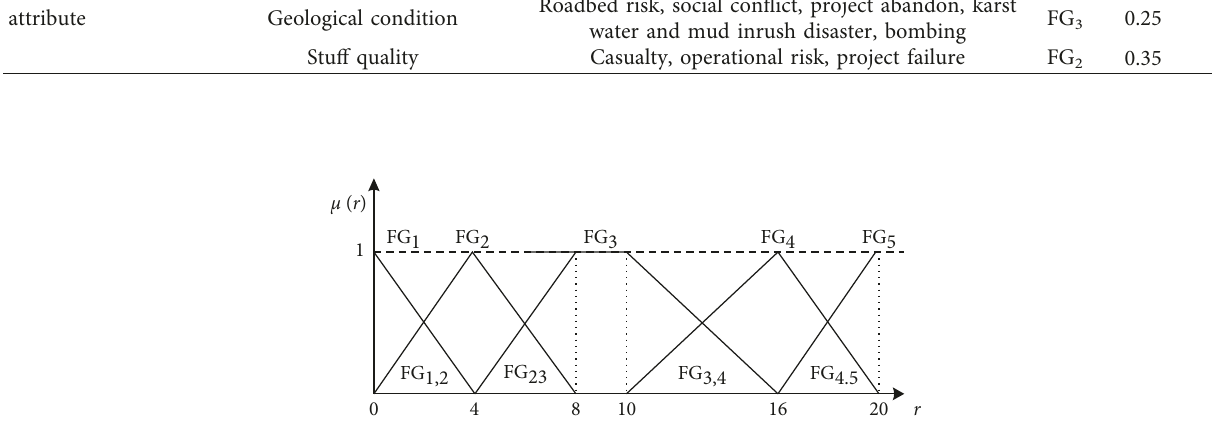
Figure 5: Fuzzy risk grade of railway project accident.